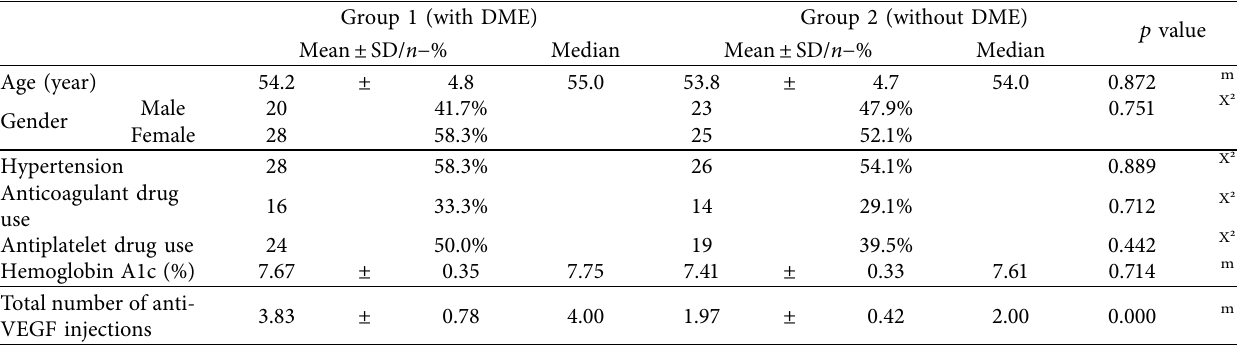
Table 1: Demographic characteristics of the groups, hypertension history, anticoagulant and antiplatelet drug use, hemoglobin A1c levels, and previous anti-VEGF injections.